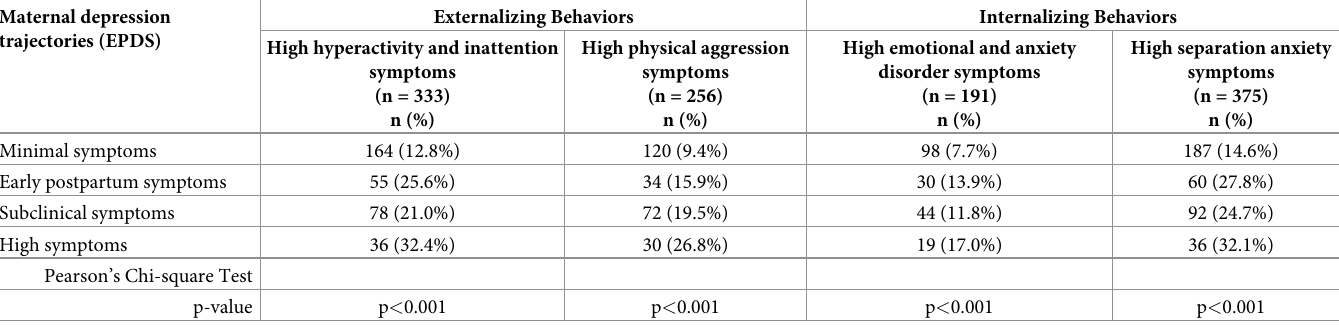
Table 4. Bivariate relationships between maternal depression trajectories and child externalizing and internalizing behavior outcomes. Maternal depression trajectories